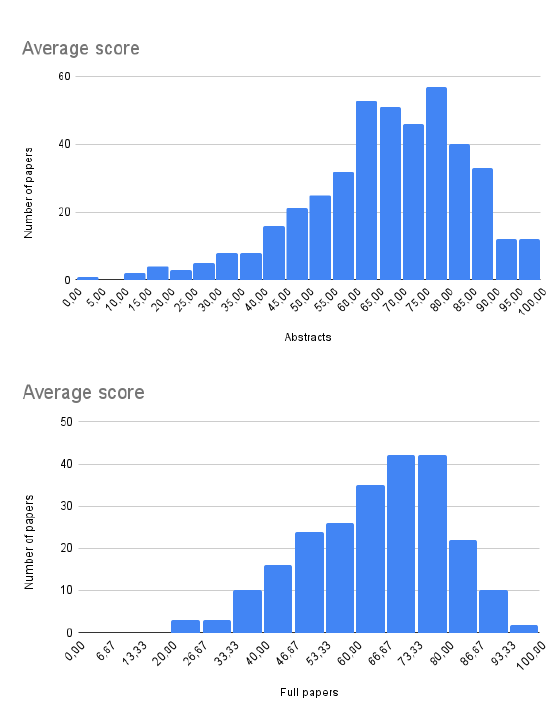
Figure 3. Average review scores for the submitted